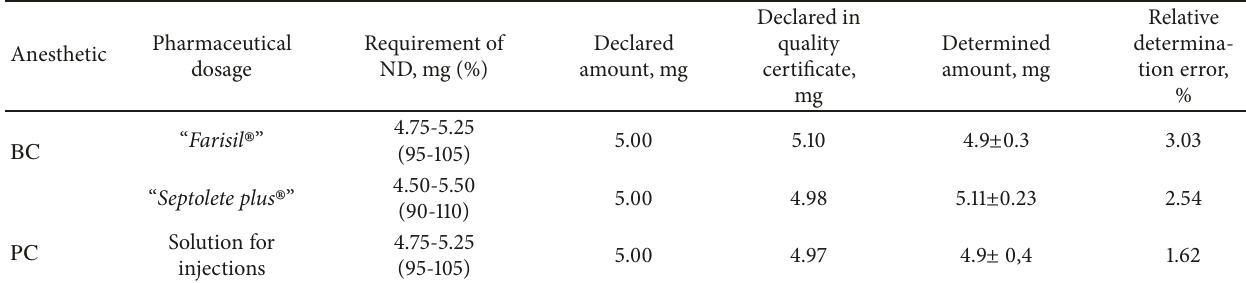
Table 5: The analysis of the pharmaceutical dosages using the proposed method ( n =